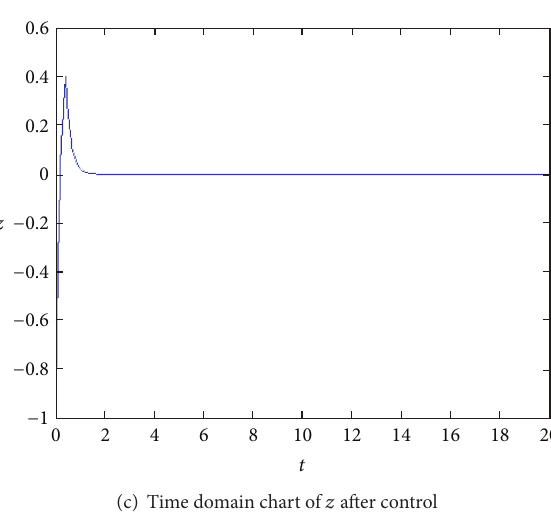
Figure 11: Time domain charts of state variables after